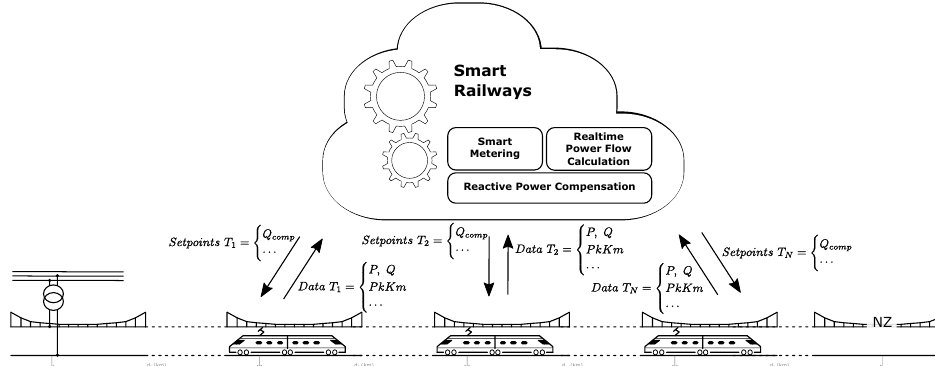
Figure 19. Integration of reactive power compensation in a smart railway